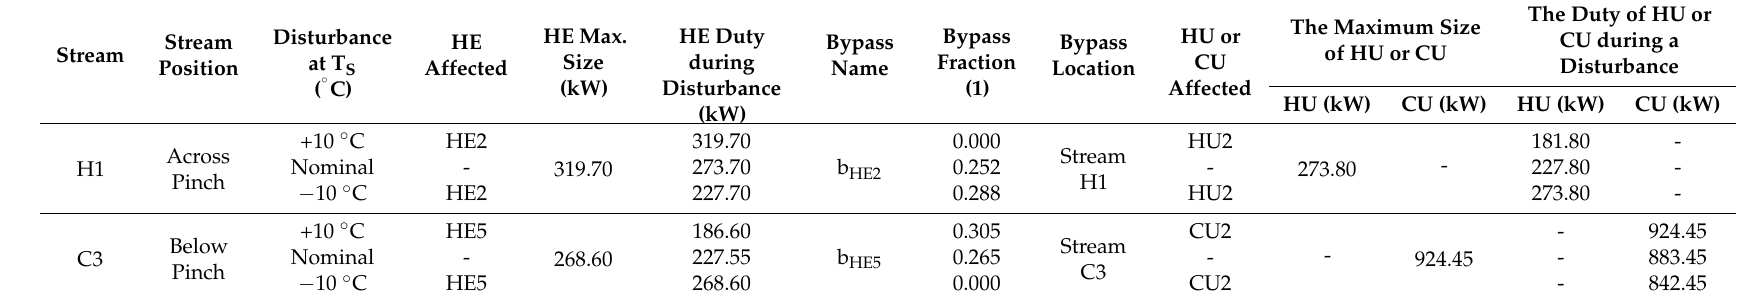
Table 7. Analysis of bypass and utility requirements of HEN design with maximum HE area.